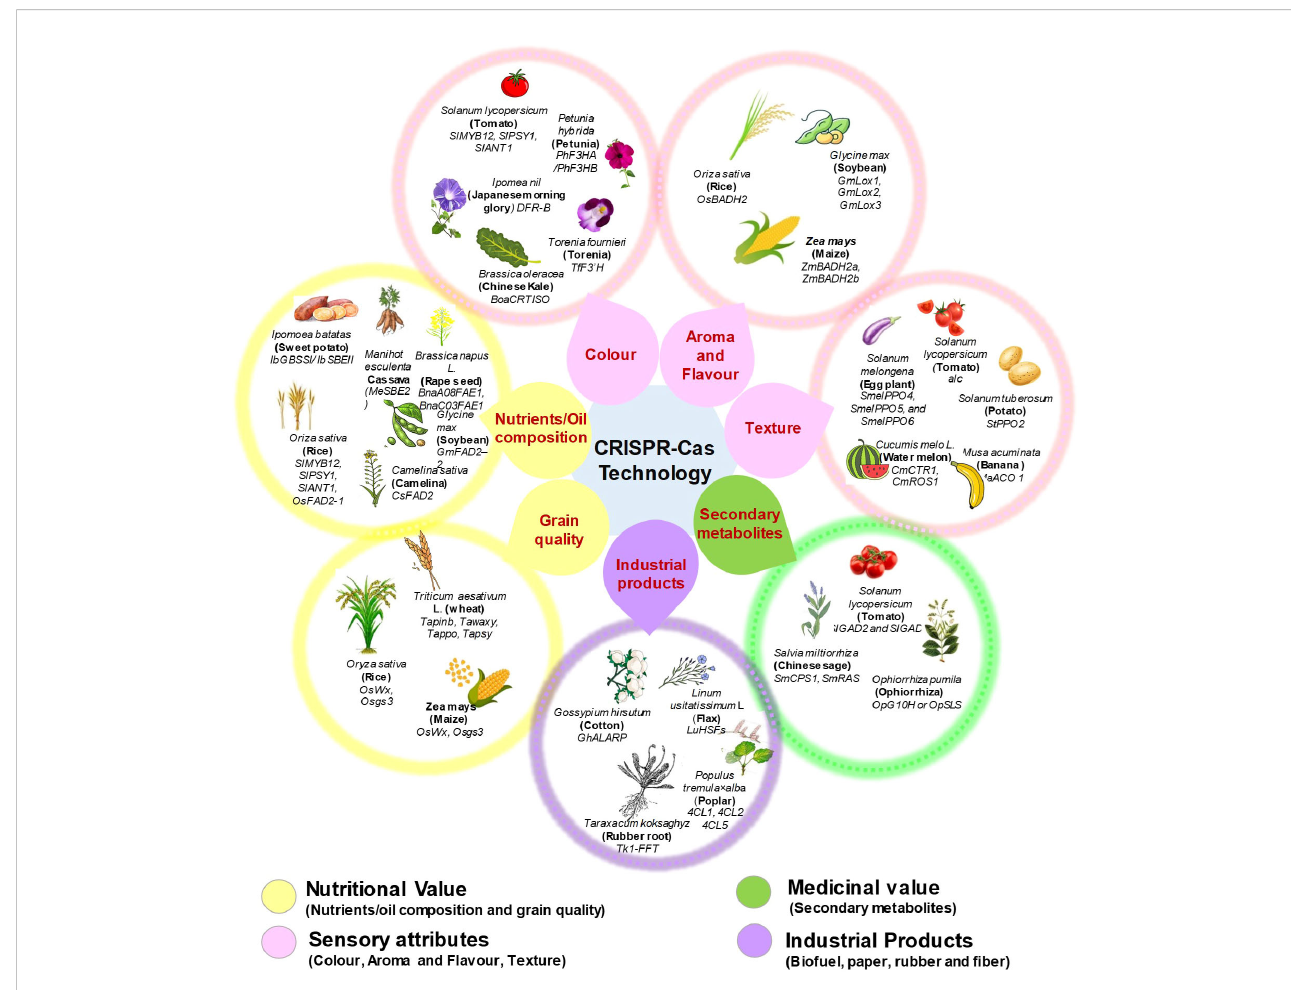
FIGURE 6 CRISPR-Cas technology based improvement of consumer preferred traits among various